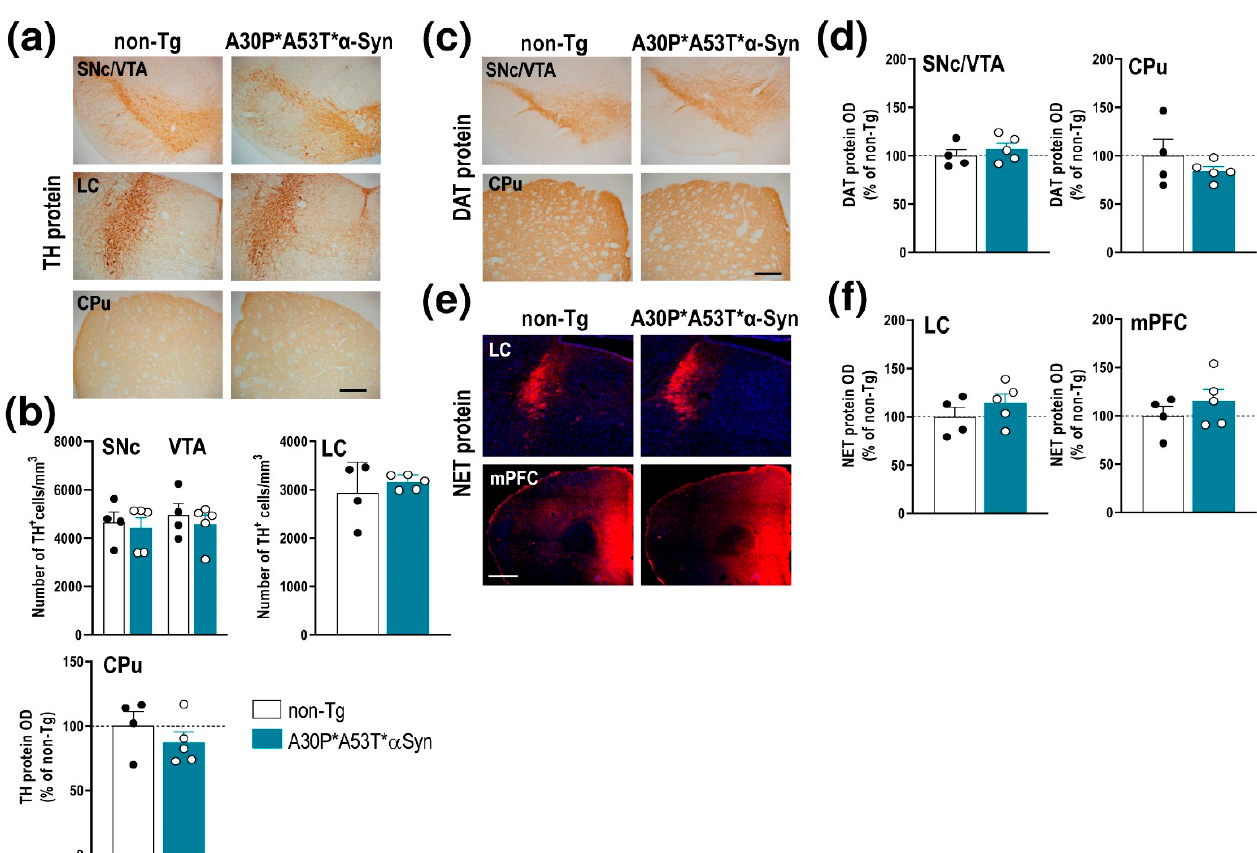
Figure 2. Integrity of DA and NE systems of middle-aged (5 months) A30P*A53T* α -Syn transgenic mice. ( a ) TH-im- munostained brain sections containing SNc/VTA, LC and CPu. Scale bar: 200 µm. ( b ) No differences in the number of TH